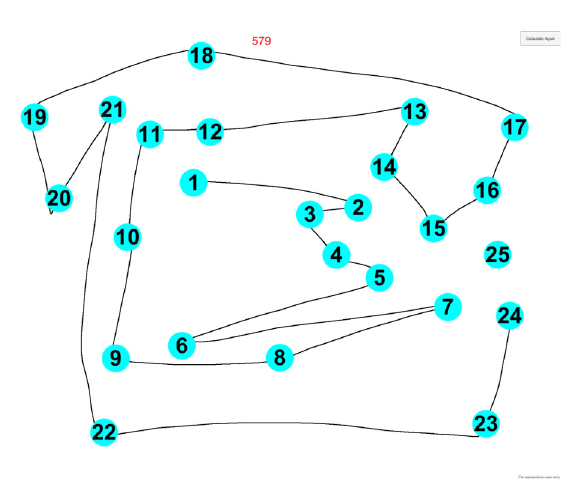
Figure 5. A screenshot